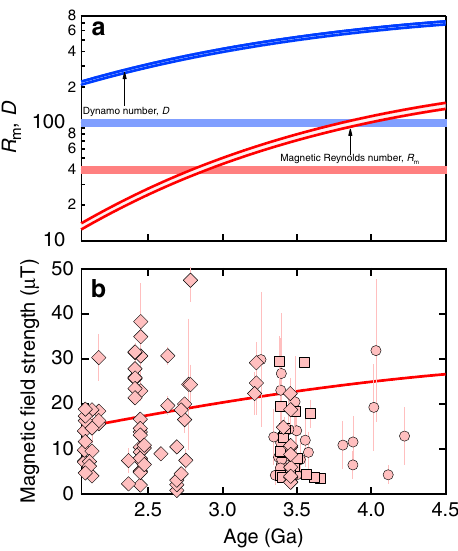
Fig. 3 Magnetic Reynolds number and magnetic fi eld strength. a The magnetic Reynolds number (red) and Dynamo number (blue) computed from our electrical conductivity results and thermal evolution model with shading indicating the difference between low-spin (top of range) and high- spin (bottom of range) results compared with the respective critical values of R m = 40 and D = 100 (thick horizontal lines). b Magnetic fi eld strength computed from our model (red line) compared with paleomagnetic data: diamonds from the PINT database 40 , and circles (Thellier – Coe method) and squares (565C method) from zircons 41 . We note that the evidence of a fi eld prior to the oldest whole-rock PINT data at 3.45 Ga relies on the single-crystal zircon results, which have been questioned as not deriving from a primary magnetic carrier 42